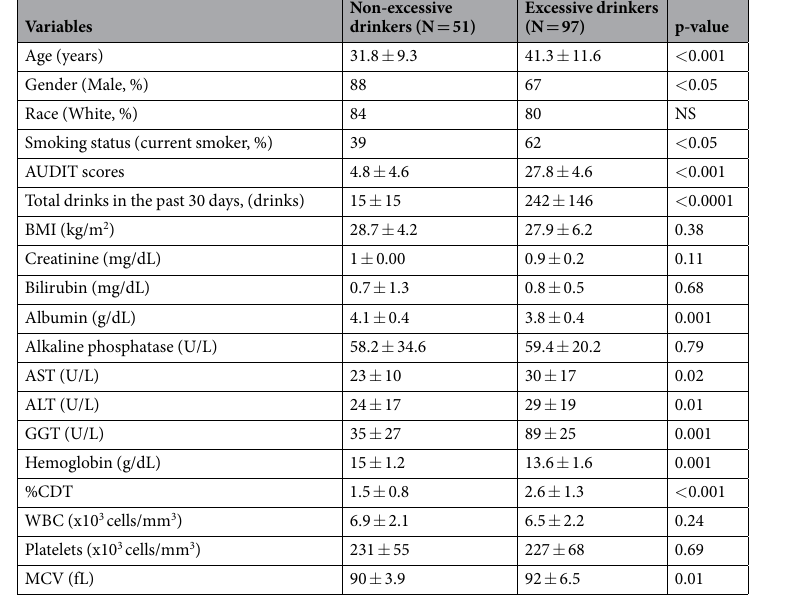
Table 1. Demographic and clinical characteristics of the study cohort (N =